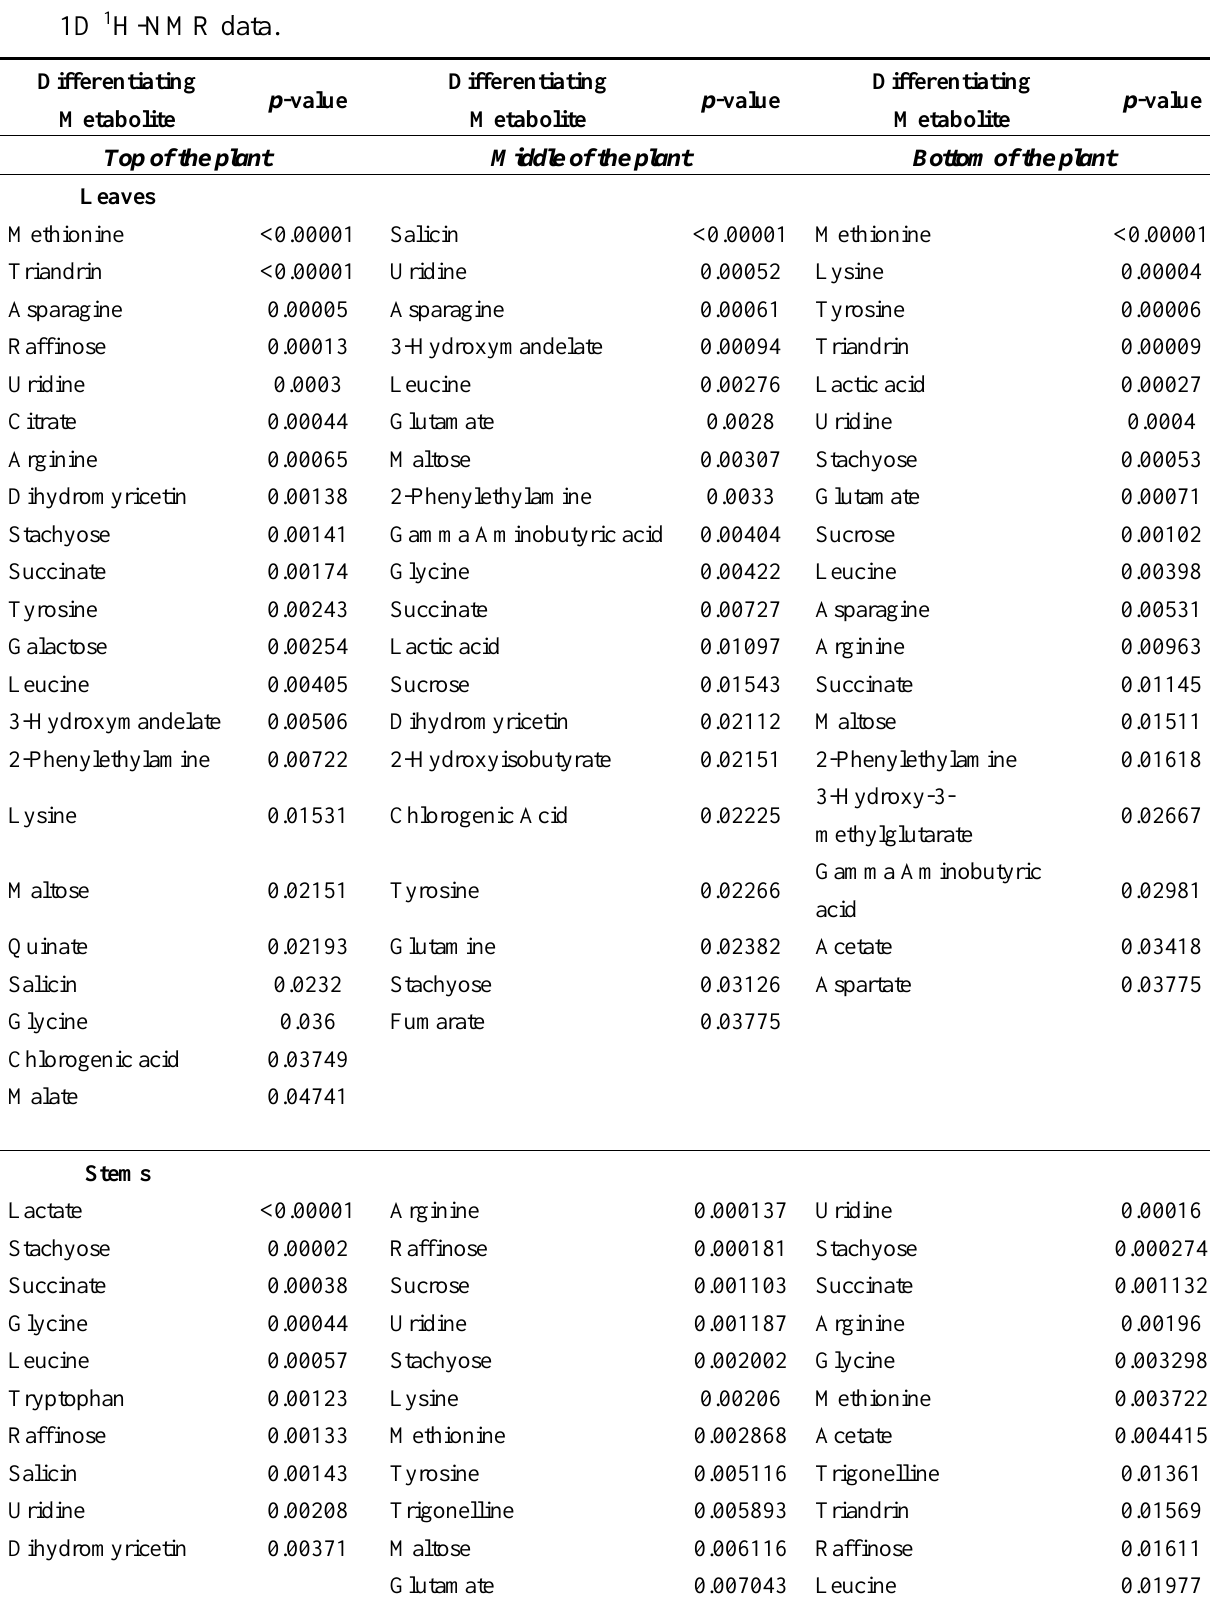
Table 4. Metabolites showing a statistically significant difference between genotypes at varying parts of the willow plant in both leaf and stem tissue. Data is derived from a one-way ANOVA analysis of Chenomx-quantified metabolite concentrations derived from 1D 1 H-NMR